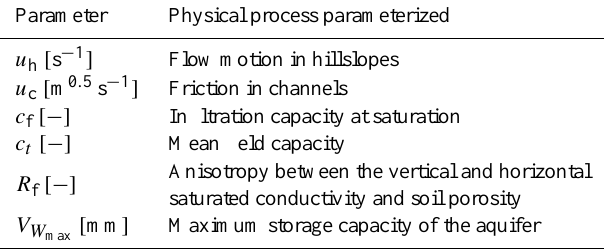
Table 1. The parameters of Continuum model that need calibration at basin scale are reported with a brief